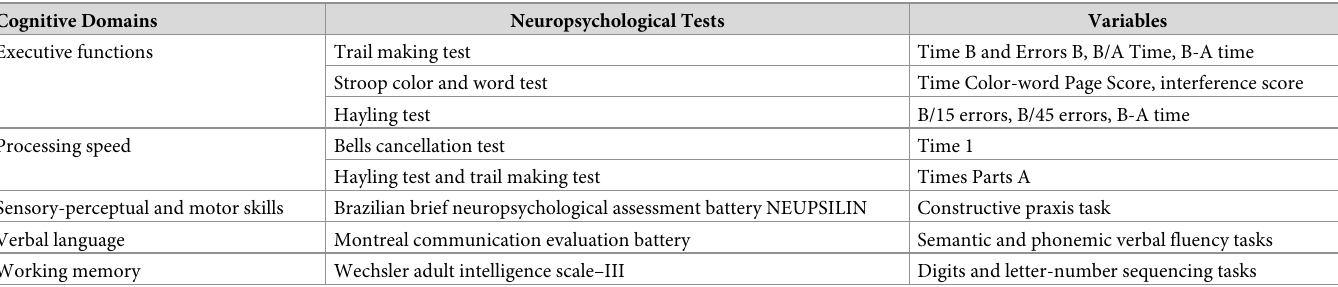
Table 2. Cognitive domains with their corresponding neuropsychological tests and specific variables for the composite